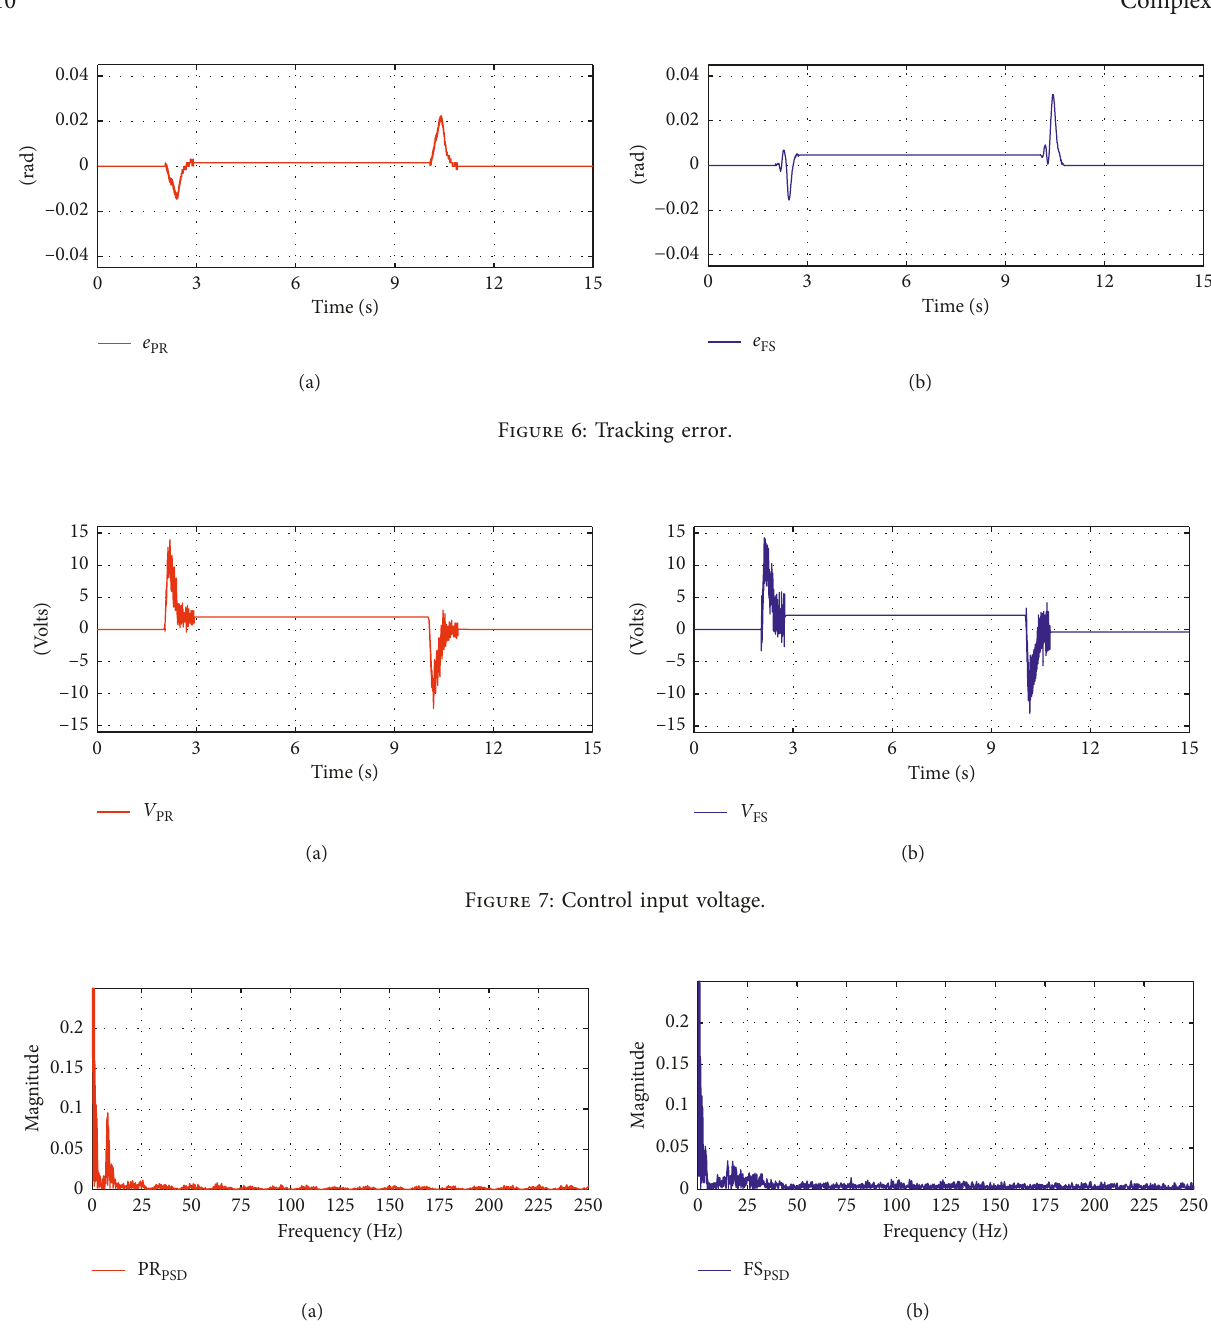
Figure 8: Power spectrum